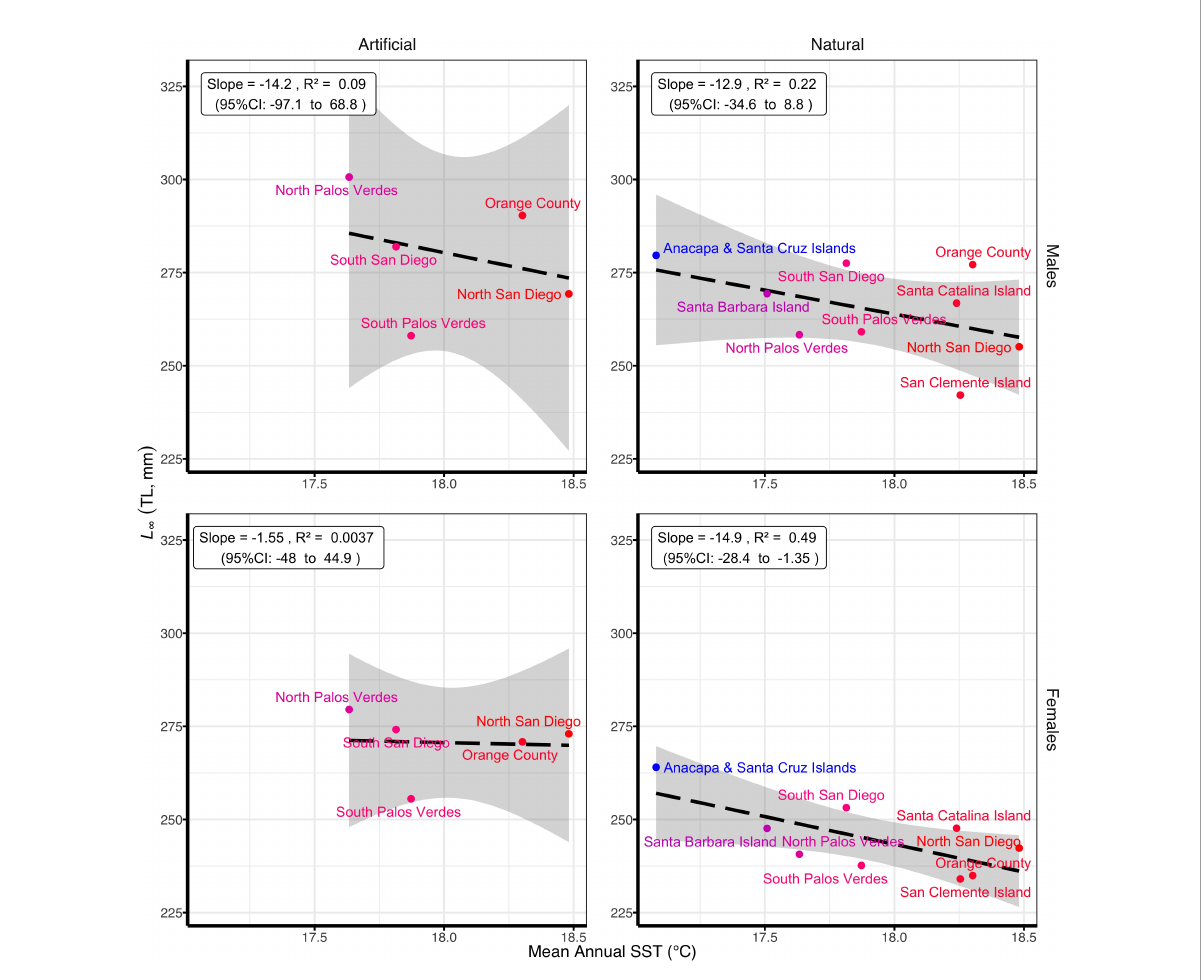
FIGURE 3 Relationship between mean asymptotic total length ( L ∞ ) of Garibaldi ( Hypsypops rubicundus) from the highest ranked (and most complex) model (Table 2) and mean annual sea surface temperature (SST; °C) for January 2002-December 2018. Locations are colored from a scale of blue (cold) to red